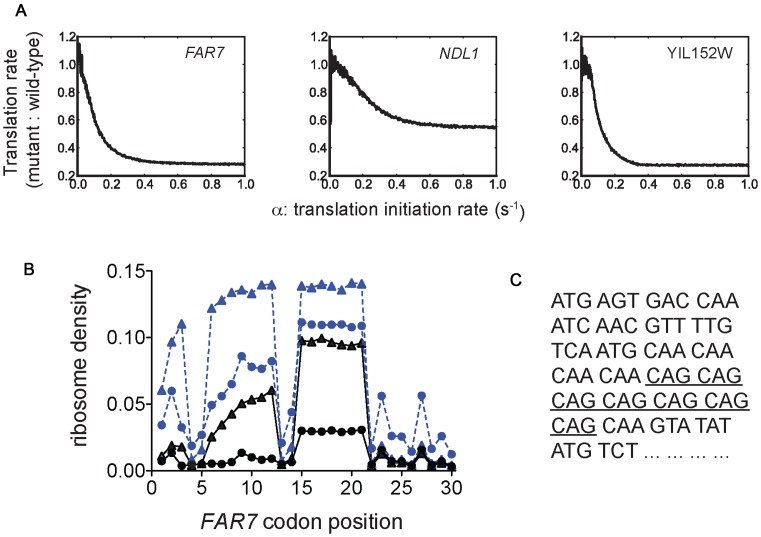
The rate of translation elongation at CAG codons, relative to the rate of translation initiation, governs ribosome queue formation and thus \documentclass[12pt]{minimal}
\usepackage{amsmath}
\usepackage{wasysym}
\usepackage{amsfonts}
\usepackage{amssymb}
\usepackage{amsbsy}
\usepackage{upgreek}
\usepackage{mathrsfs}
\setlength{\oddsidemargin}{-69pt}
\begin{document}
}{}${\rm{tRNA}}_{{\rm{Gln}}}^{{\rm{CUG}}}$\end{document} sensitivity. (A) TASEP simulation of translation of three \documentclass[12pt]{minimal}
\usepackage{amsmath}
\usepackage{wasysym}
\usepackage{amsfonts}
\usepackage{amssymb}
\usepackage{amsbsy}
\usepackage{upgreek}
\usepackage{mathrsfs}
\setlength{\oddsidemargin}{-69pt}
\begin{document}
}{}${\rm{tRNA}}_{{\rm{CUG}}}^{{\rm{Gln}}}$\end{document}-sensitive mRNAs was conducted across a range of values of α, the translation initiation rate (Figure 2). Simulations were conducted in either a wild-type tRNA background, or a sup70-65 tRNA background, and a ratio of these translational efficiencies plotted against each value of the translation initiation rate. (B) These same TASEP simulations were used to record the codon-specific ribosomal density across the FAR7 ORF to indicate the positions of ribosome queuing. The ribosomal density across the FAR7 was recorded in a wild-type strain (filled circle symbols) and the sup70-65 mutant condition (open triangle symbols), at the physiological initiation rate of 0.3 events/s (dashed lines, blue symbols), and again at a 6-fold slower rate of 0.05 events/s (solid lines). The ribosomal density across codons 1–30 is presented, showing that the ribosomal density at the mRNA 5′ end in the sup70-65 mutant is greater than that in the wild-type at the high initiation rate, but that ribosome queues dissipate at the lower initiation rate, eliminating this density differential at the 5′-most codons. (C) Codons 1–24 of the FAR7 open reading frame, with the positions of the CAG codons indicated (underlined).